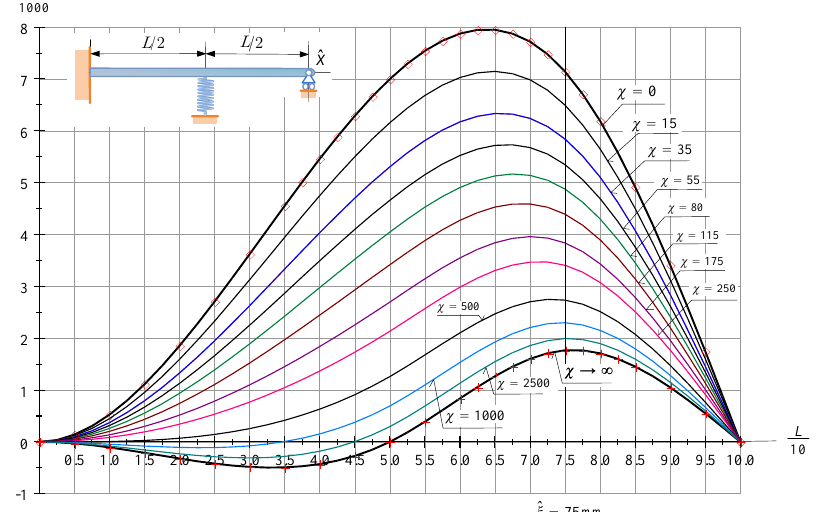
Figure 3. The Green function (the dimensionless vertical displacement field) of an FssP beam subjected to a dimensionless unit force at ξ =